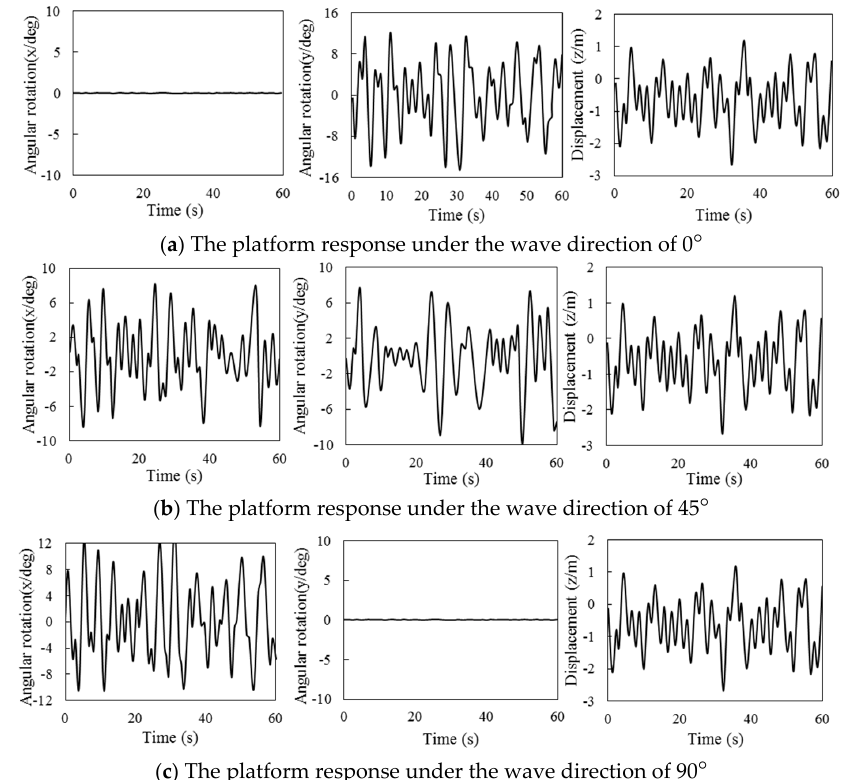
Figure 10. The platform response under wind − sea scale 5 with different wave directions.